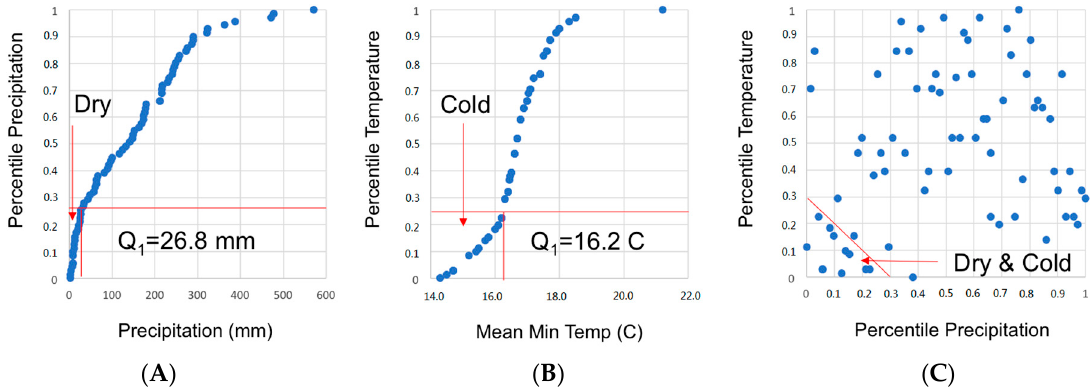
Figure 1. Scatter plots illustrating relationships between monthly precipitation values and their percentiles ( A ), monthly temperature values and their percentiles ( B ), and the joint percentiles for mean minimum temperature and precipitation identifying the cold and dry regiment ( C ), for 2010–2015 in the Central Valley of Costa